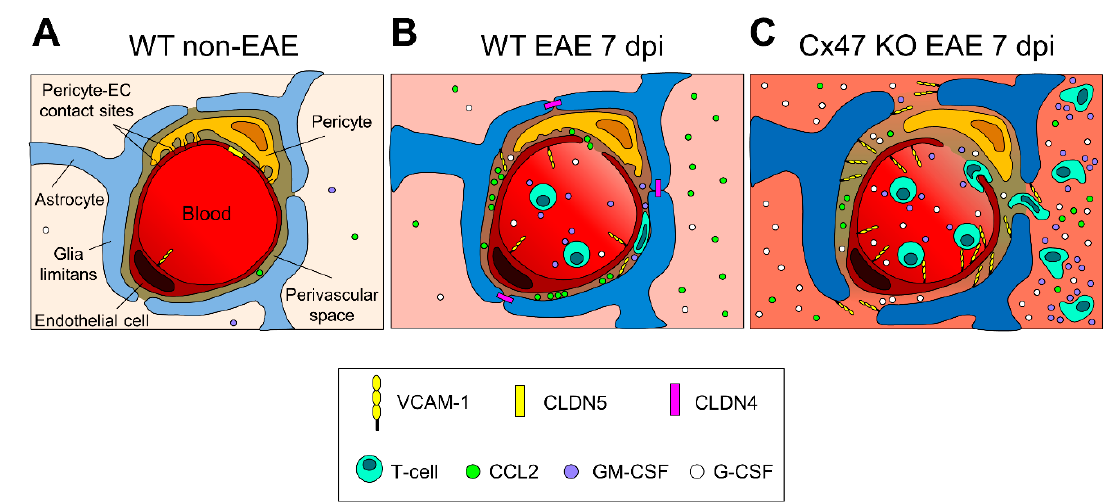
Figure 8. Proposed diagrammatic representation of the glio-vascular interface differences between the 6–8 weeks old WT EAE and Cx47 KO EAE mice at pre-onset EAE. ( A ) In the non-inflamed glio-vascular interface of WT mice, the BBB/BSCB is sealed by endothelial CLDN5-based TJs, glia limitans end-feet are not reactive and do not express CLDN4-based TJs, and pericytes form contact sites with endothelial cells (ECs). CCL2, VCAM-1, GM-CSF, and G-CSF are expressed at low levels. ( B ) In the inflamed glio-vascular interface of WT EAE mice at 7 dpi, endothelial CLDN5-based TJs are downregulated opening the BBB/BSCB, and ECs upregulate VCAM-1 expression, attracting primed T-cells to the perivascular space (PVS). Glia limitans end-feet become reactive and express CLDN4-based TJs sealing the glia limitans barrier, thus impeding access of incoming primed T-cells to the CNS parenchyma. ( C ) In the inflamed glio-vascular interface of Cx47 KO EAE mice at 7 dpi, endothelial CLDN5-based TJs are more downregulated and VCAM-1 is more upregulated than in WT EAE mice ( B ), attracting more primed T-cells from the periphery into the PVS. G-CSF, and GM-CSF are also more upregulated, and glia limitans end-feet are more reactive. At the PVS, primed T-cells cleave CLDN4-based TJs and open the glia limitans barrier, making their entry into the CNS parenchyma where they keep secreting cytokines augmenting the CNS inflammatory process. Under inflammatory conditions ( B and C ), stimulated pericytes hypothetically downregulate their contact sites with ECs and detach from them.